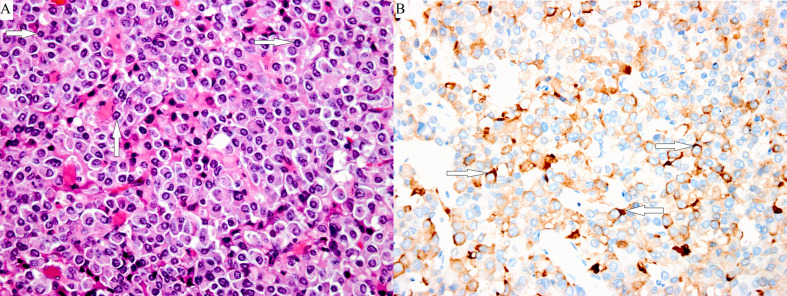
Poorly differentiated Pit-1 lineage tumor cells with chromophobic to variably eosinophilic cytoplasm and occasionally prominent nucleoli. The cell nuclei show prominent structures that correspond to spheridia, as indicated by the white arrows. (A: hematoxylin-eosin stain, magnification ×400). A few tumor cells were positive for TSHβ, as indicated by the white arrows (B: immunoperoxidase stain, magnification ×400).